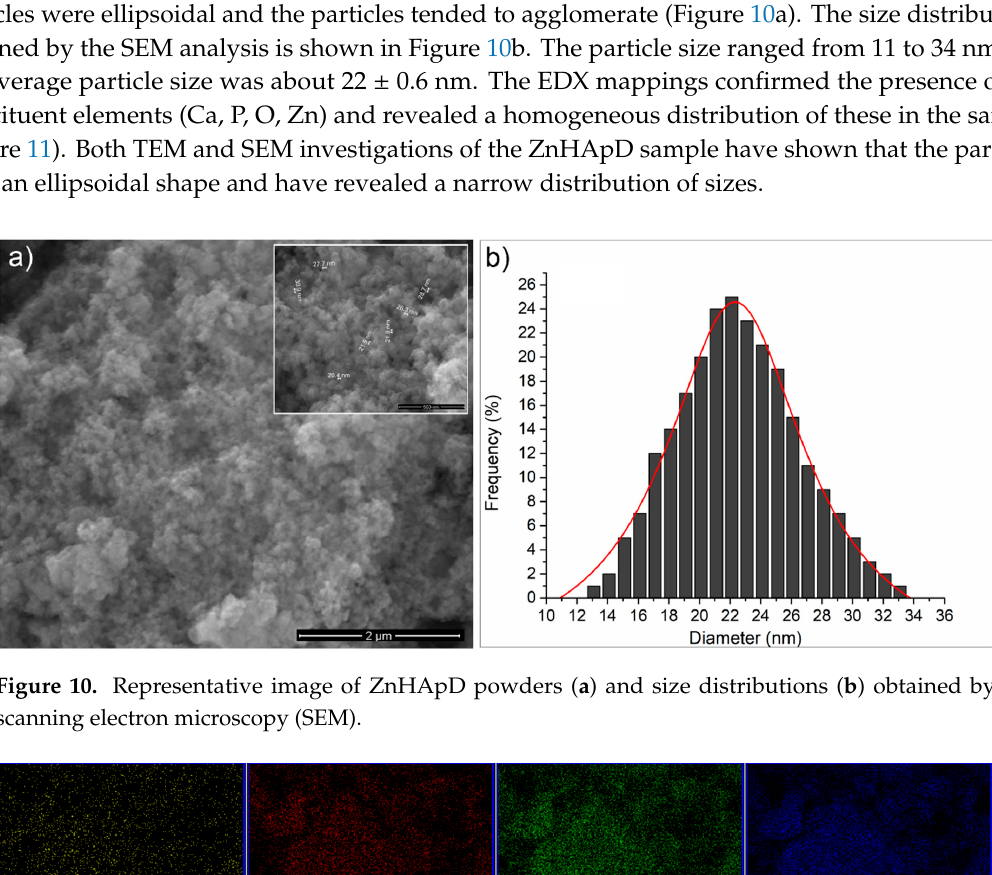
Figure 11. The energy dispersive spectroscopy (EDX) mappings of of ZnHApD powders. Different concentrations (62.5, 125, 250 and 500 μ g/mL) of the ZnHApD solution were added to HEK-293 cells and analyzed after 24 and 48 hours, respectively. The results obtained are shown in Figure 12. As can be seen in Figure 12, the ZnHApD nanoparticles exhibited a non-toxic activity against HEK-293 cells at all concentrations analyzed. After 24 h, cell viability was 90–98%. At a concentration of 500 μ g/mL, the cell viability was 90%, while in case of lower dosages (62.5 and 125 μ g/mL) the cell viability was 98%. A 95% cell viability was observed at the concentration of 250 μ g/mL. After an 48h incubation of HEK-293 cells with different concentrations of ZnHApD solution the results concerning the cell viability were similar to those obtained at 24 h for concentrations of